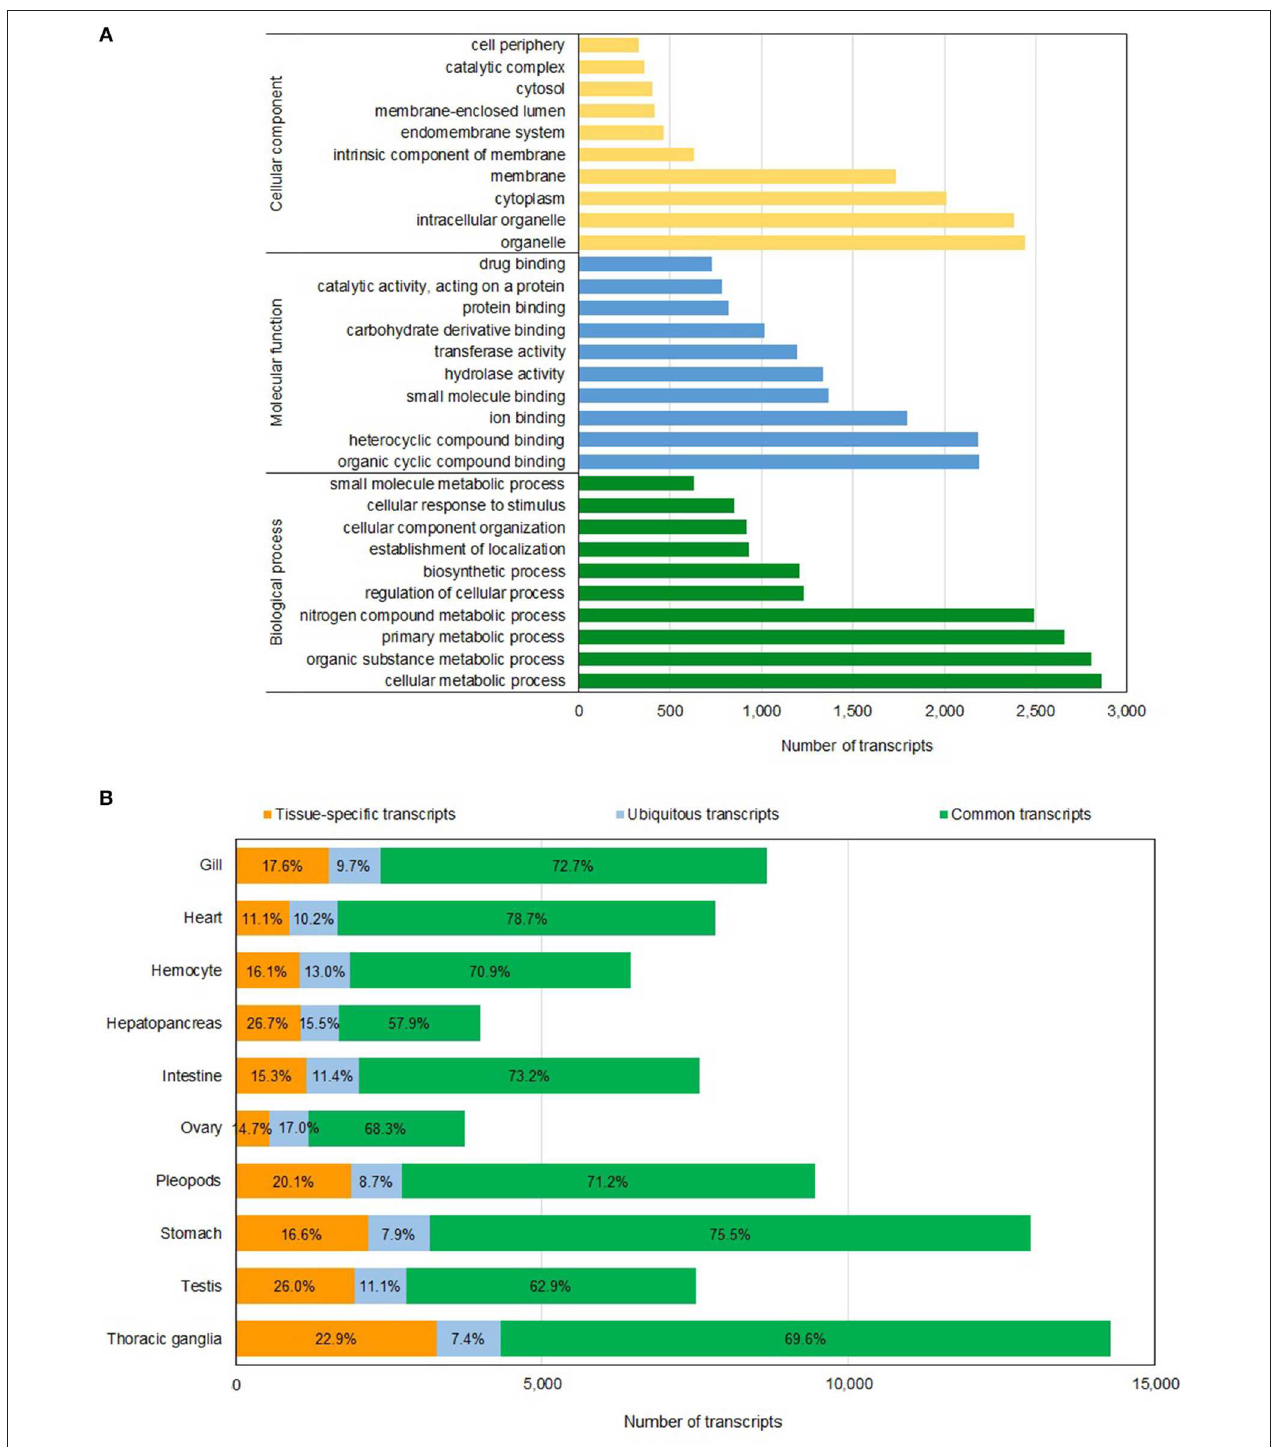
FIGURE 1 | Gene annotation and transcript distribution. (A) Distribution of functional categories based on GO terms in P. monodon transcriptome assembly. (B) Distribution of transcripts in each tissue type based on their presence in the tissues studied. Tissue-specific transcripts (orange bar) are present in only one tissue type; ubiquitous transcripts (blue bar) are present in all tissue types, and common transcripts (green bar) are present in more than one tissue type but not detected in all tissues examined. The number represents the percentage of each transcript category in each tissue type.